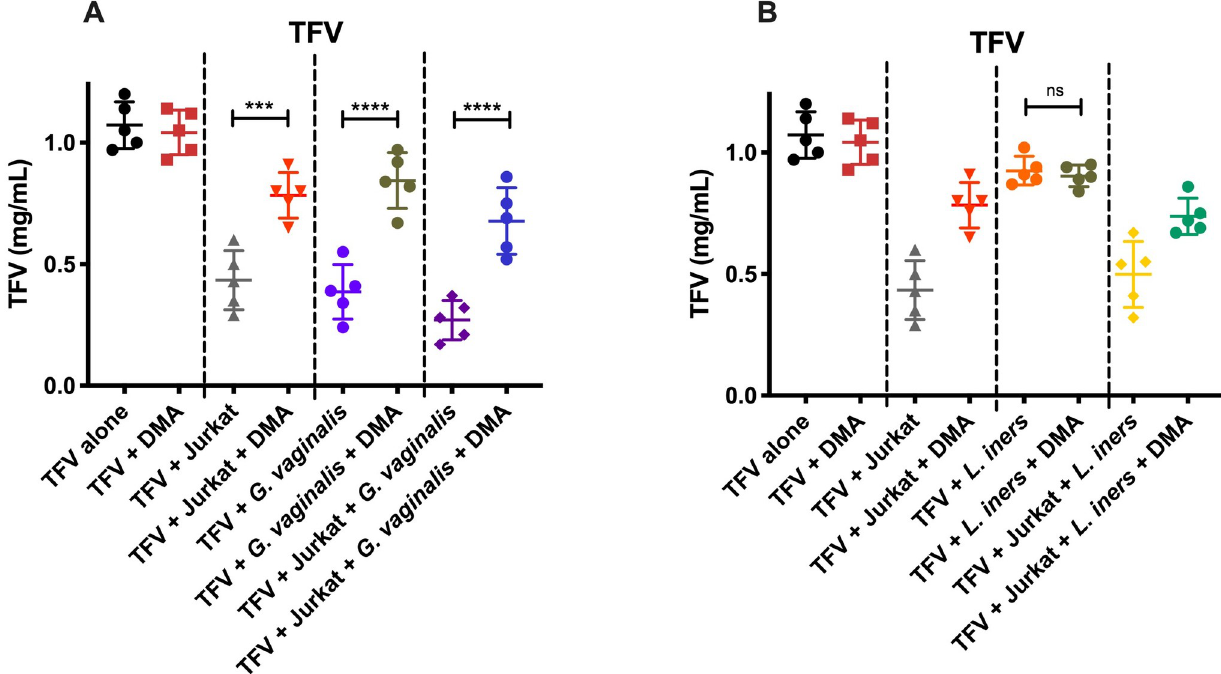
Fig 9. TFV remaining after Incubation with endocytosis inhibitor, DMA. (A) TFV remaining after 24 hours based on 1) TFV alone (black) 2) TFV + DMA (red) 3) TFV + Jurkat (gray) 4) TFV + Jurkat + DMA (dark orange) 5) TFV + G . vaginalis (purple) 6) TFV + G . vaginalis + DMA (dark green) 7) TFV + Jurkat + G . vaginalis (dark purple) 8) TFV + Jurkat + G . vaginalis + DMA (dark blue). Jurkat cells were exposed to 100uM DMA for 30 min prior to treatment with TFV (1mg/mL) and G . vaginalis . Co-culture experiments were added at a 2.5:1 ratio of bacteria to cells. N = 5. (B) TFV remaining after 24 hours based on 1) TFV alone (black) 2) TFV + DMA (red) 3) TFV + Jurkat (gray) 4) TFV + Jurkat + DMA (dark orange) 5) TFV + L . iners (orange) 6) TFV + L . iners + DMA (dark green) 7) TFV + Jurkat + L . iners (yellow) 8) TFV + Jurkat + L . iners + DMA (teal). Jurkat cells were exposed to 100uM DMA for 30 min prior to treatment with TFV (1mg/mL) and L . iners . Co-culture experiments were added at a 2.5:1 ratio of bacteria to cells. N = 5.